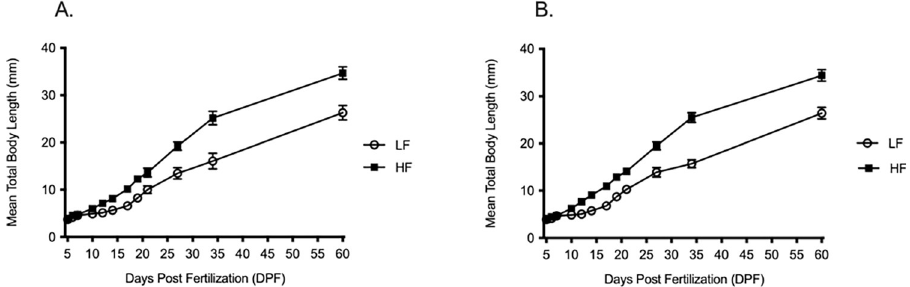
Fig 2. Growth curves of two F 0 wild-type strains from 5 to 60 DPF. Mean total body length for two F 0 generation wild-type strains, (A) AB and (B) Tu¨. Growth curves are represented by mean ± standard deviation. Open circles = LF, closed squares =